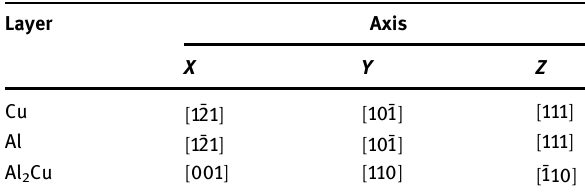
Table 2: The initial orientation of Cu, Al and Al 2 Cu layers Layer